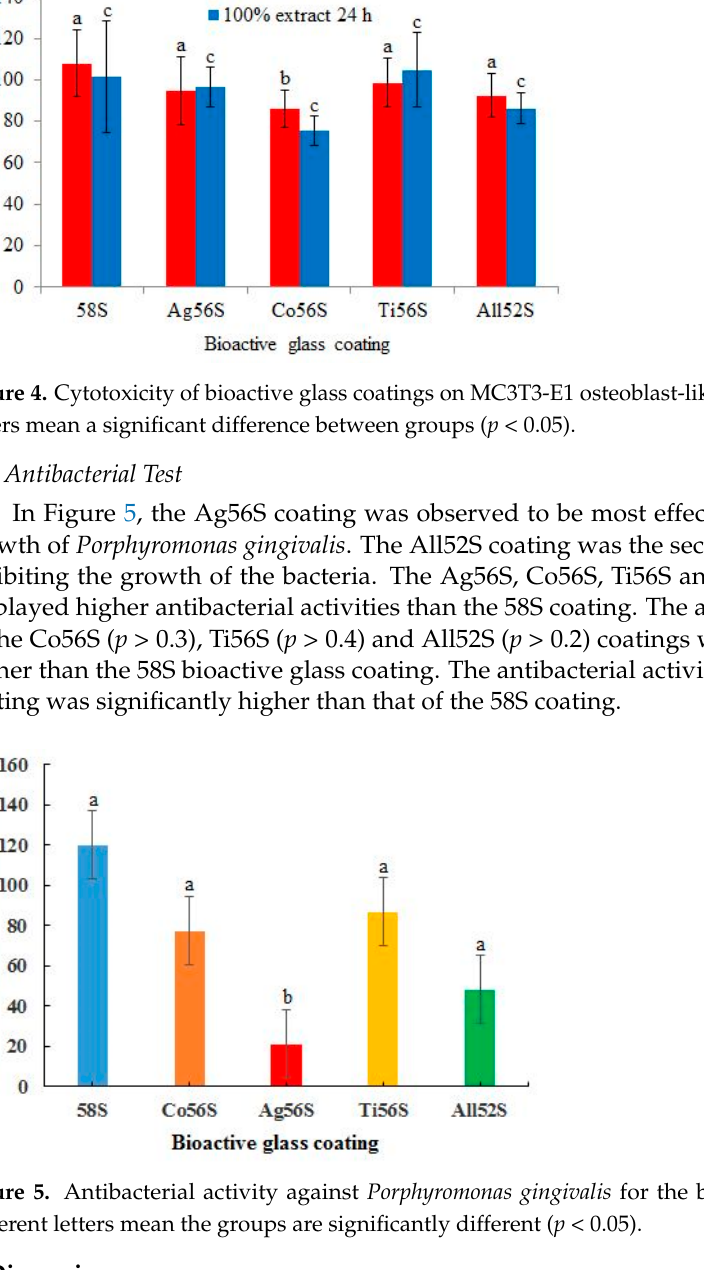
Figure 5. Antibacterial activity against Porphyromonas gingivalis for the bioactive glass coatings. Different letters mean the groups are significantly different ( p < 0.05).